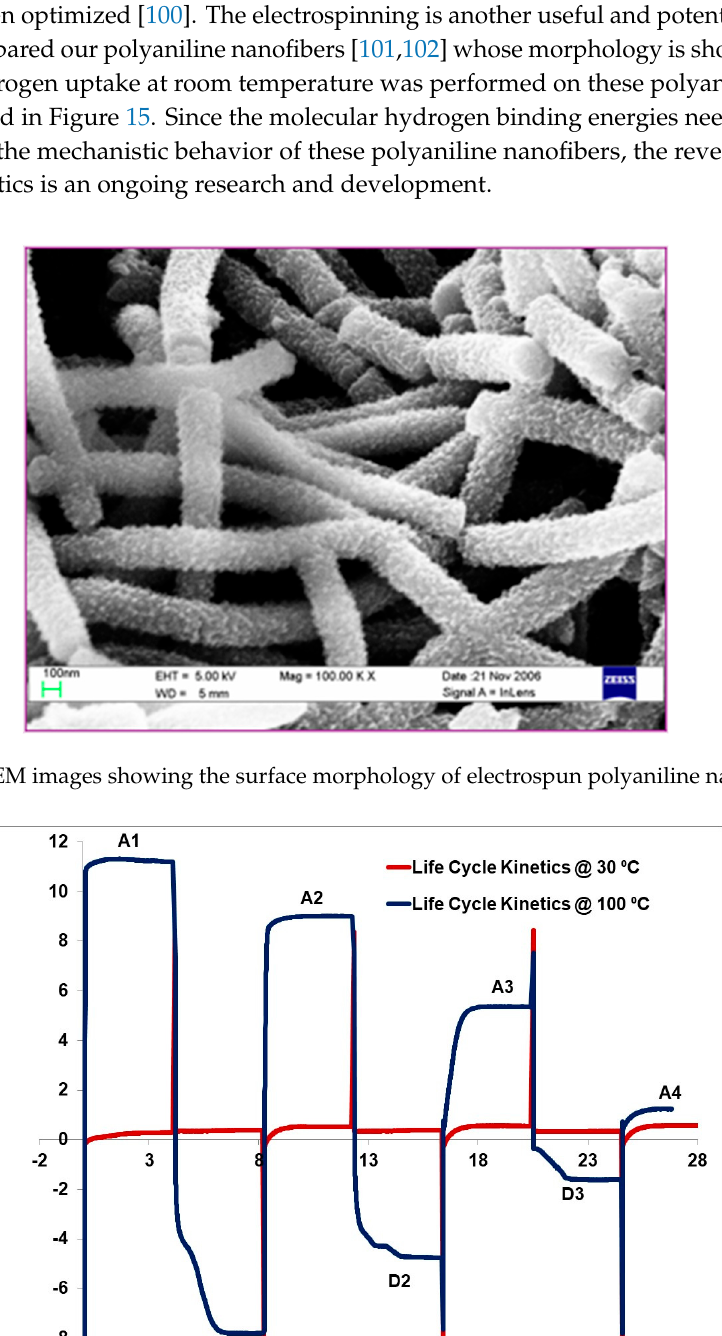
Figure 15. Hydrogen sorption cycle-life of electrospun polyaniline nanofiber at 100 °C. A1-A4: Absorption in four consecutive run and D1-D3: desorption after every hydrogen absorption for three consecutive runs.